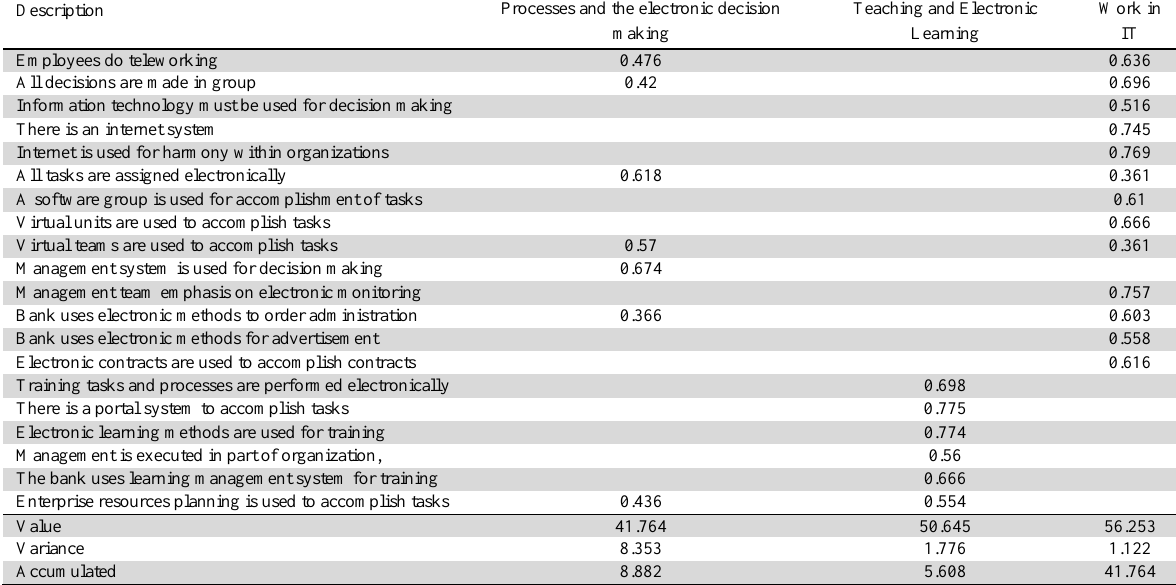
The summary of principal component analysis after rotation for internal